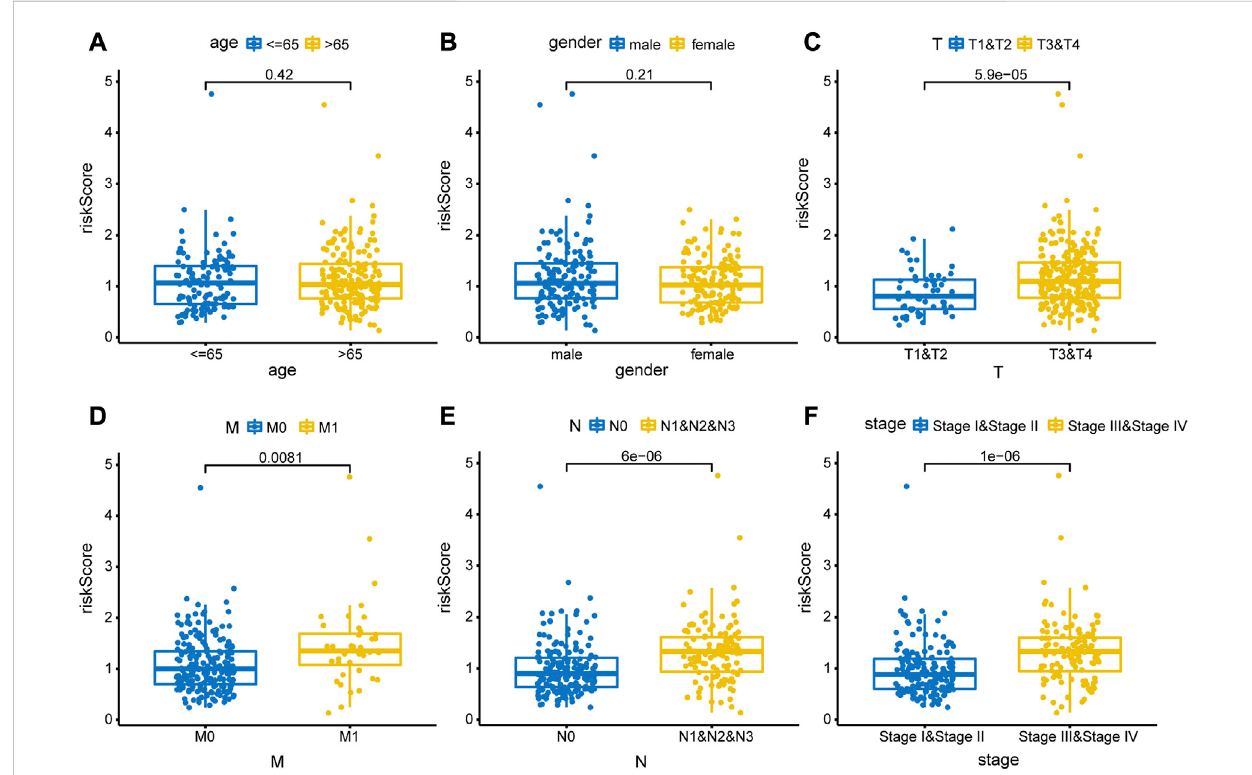
FIGURE 8 Correlationsbetweenrisk score and clinical feature. The clinical features included (A) age ( > 65 years vs. < 65 years old), (B) sex (male vs. female), (C) T stage (T1&T2 vs. T3&T4), (D) M stage (M0 vs. M1), (E) N stage (N0 vs . N1&N2), and (F) pathological stage (stage Ⅰ & stage Ⅱ vs. stage Ⅲ & stage Ⅳ